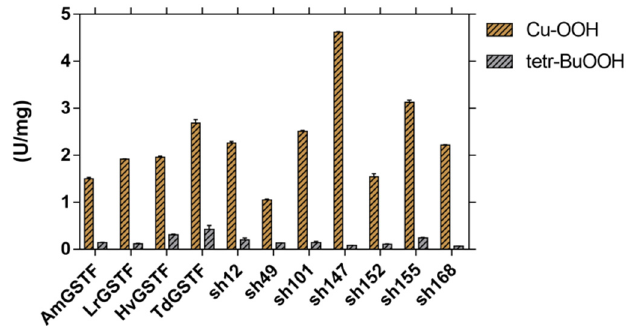
Figure 2. The glutathione-dependent peroxidase activity of the parent GSTFs and shuffled enzyme variants. The glutathione-dependent peroxidase activity was assayed using as substrates cumene hydroperoxide (CuOOH) and tert-butyl hydroperoxide (tert-BOOH).